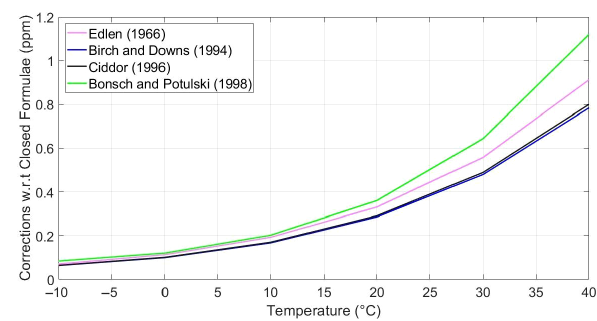
Figure 8. Comparison of EDM corrections w.r.t Closed Formulae